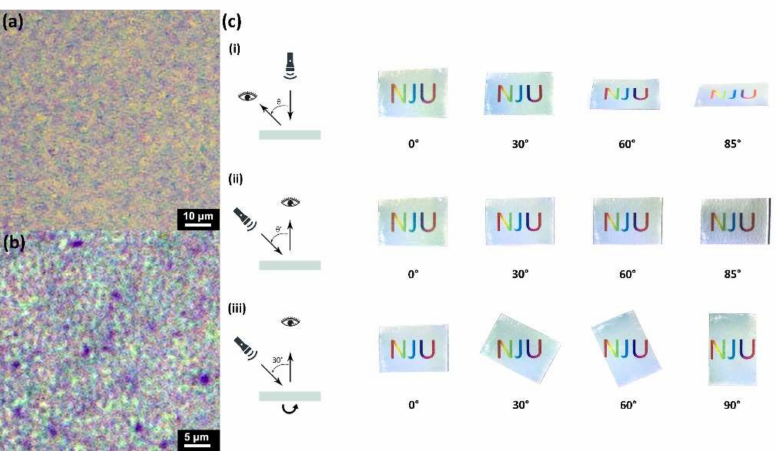
Figure 6. Microscopic images of Au nanomesh film (the f 43% sample) at ( a ) 500 and ( b ) 1000 times magnification. ( c ) Optical images showing the structural color of the Au nanomesh film when varying ( i ) the viewing angle, ( ii ) the angle of light incidence and ( iii ) the orientation of substrate (the incident light angle is fixed at 30 ◦ ).